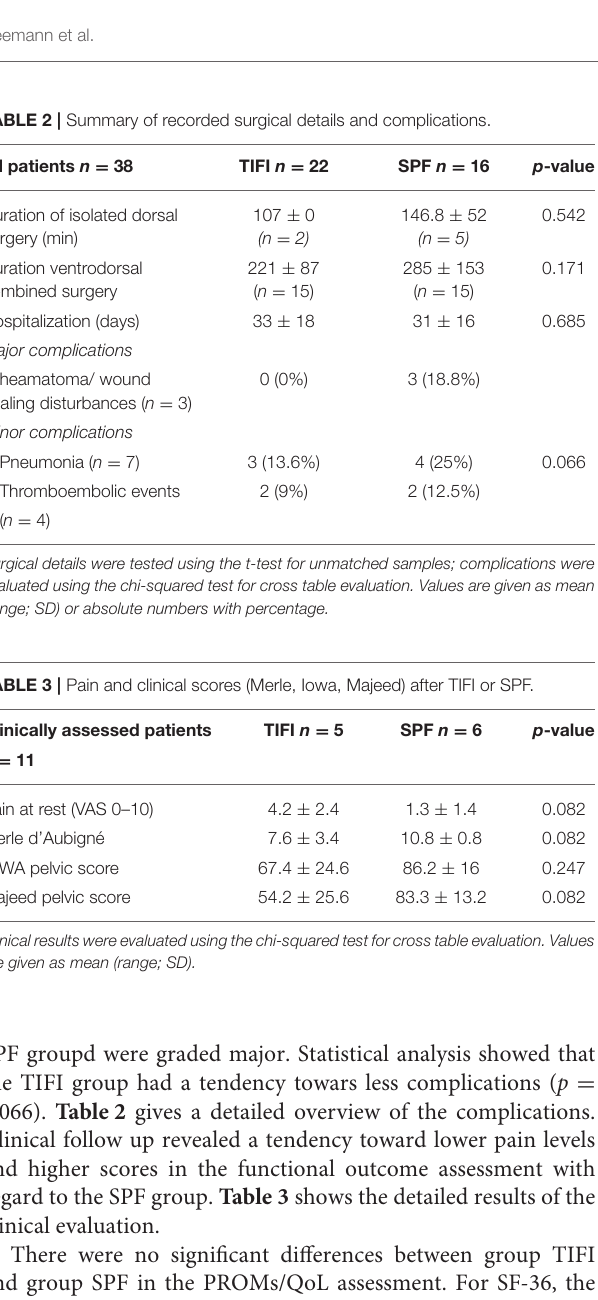
TABLE 2 | Summary of recorded surgical details and complications.